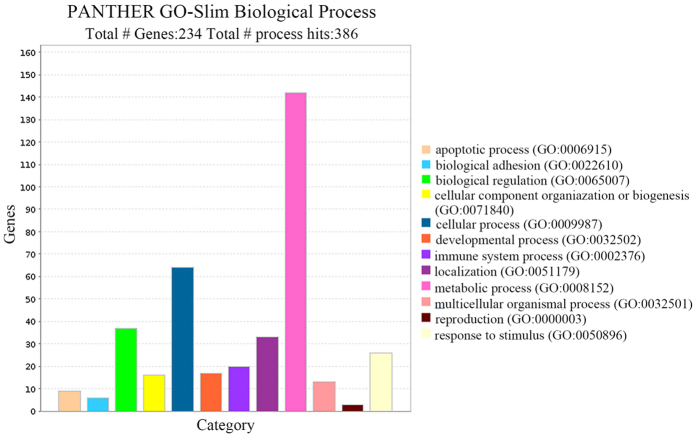
Showing biological process annotation.Bar charts display the 12 biologic processes of genes co-expressed with SMP30.